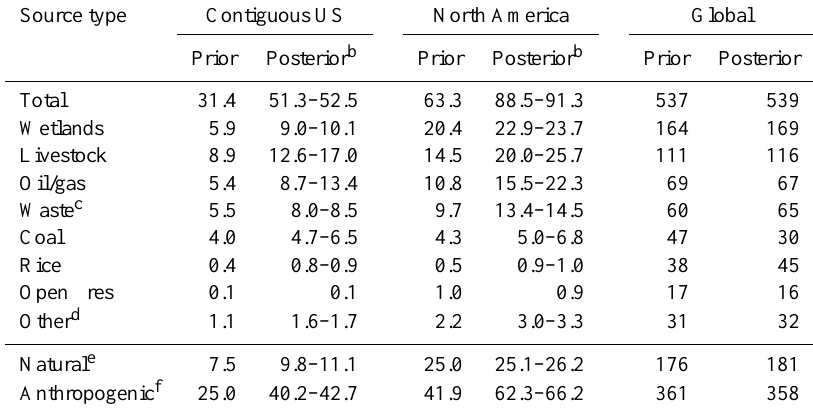
Table 1. 2009–2011 methane emissions a